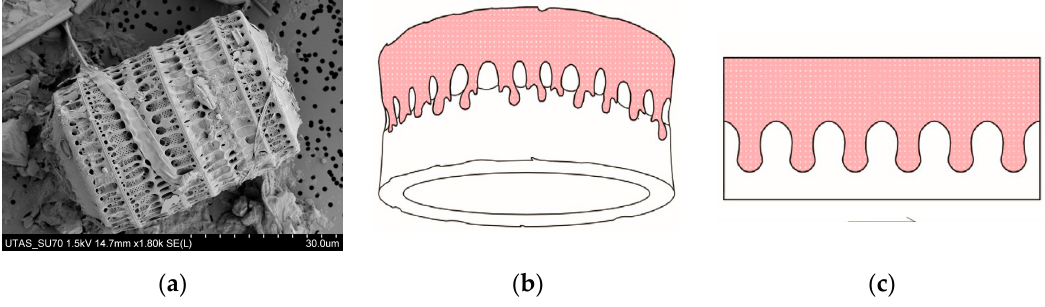
Figure 5. ( a ) Paralia sulcata diatom imaged using the University of Tasmania scanning electron microscope (cc) creative commons; ( b ) Simplification of biological role model of stacking system; ( c ) Biological stacking system translated into architectonic approach of modular Design for Dismantling. ( b , c ): © A. Coban and V. Ivanova; BioMat/ITKE—University of Stuttgart.